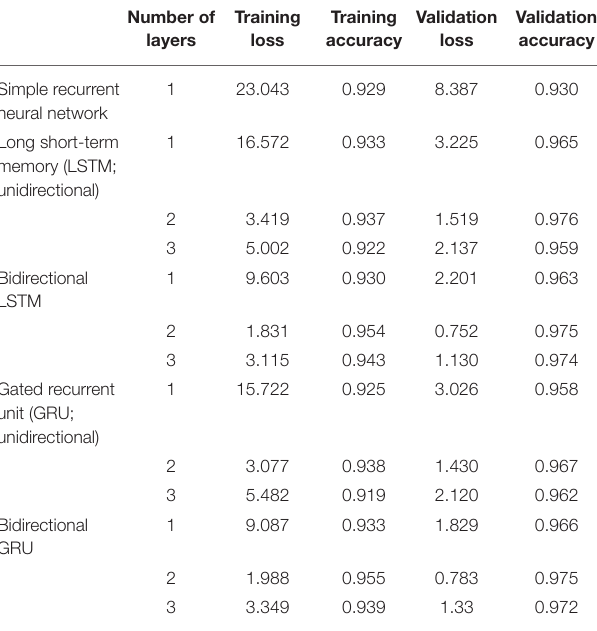
TABLE 3 | Network comparison (1,000 epochs). TABLE 4 | Results with each dataset [bidirectional long short-term memory (LSTM) with two LSTM layers, 1,000